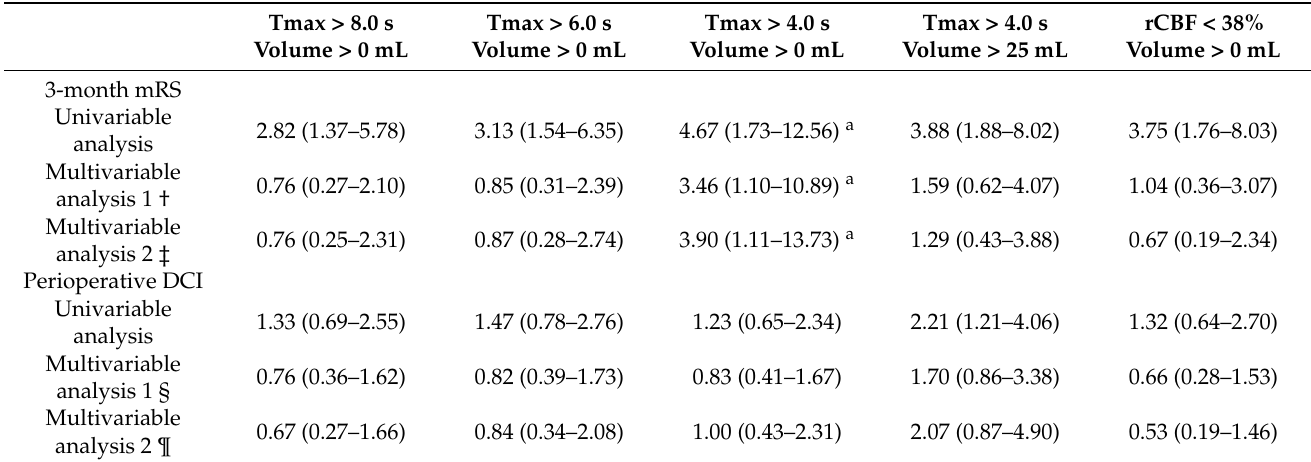
Table 3. Univariable and multivariable logistic analysis of RAPID-based CTP parameters in predicting 3-month mRS * and perioperative DCI #.